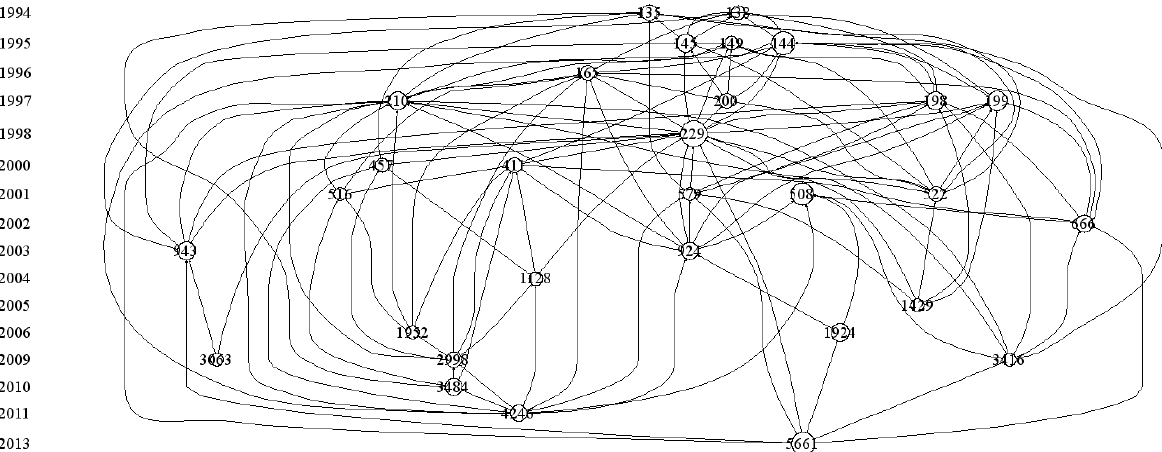
Figure 5. A citation analysis network of the top 30 publications on phytoremediation using HistCite Pro, based on data obtained from the Web of Science Core Collection (WoSCC). On the left is the year, and on the right are publications for the corresponding year. Each circle represents a publication, and the larger the circle, the more citations. The numbers in the circles were given by HistCite Pro. The numbers in the circles and their publications are: 135 [60], 138 [65], 144 [66], 145